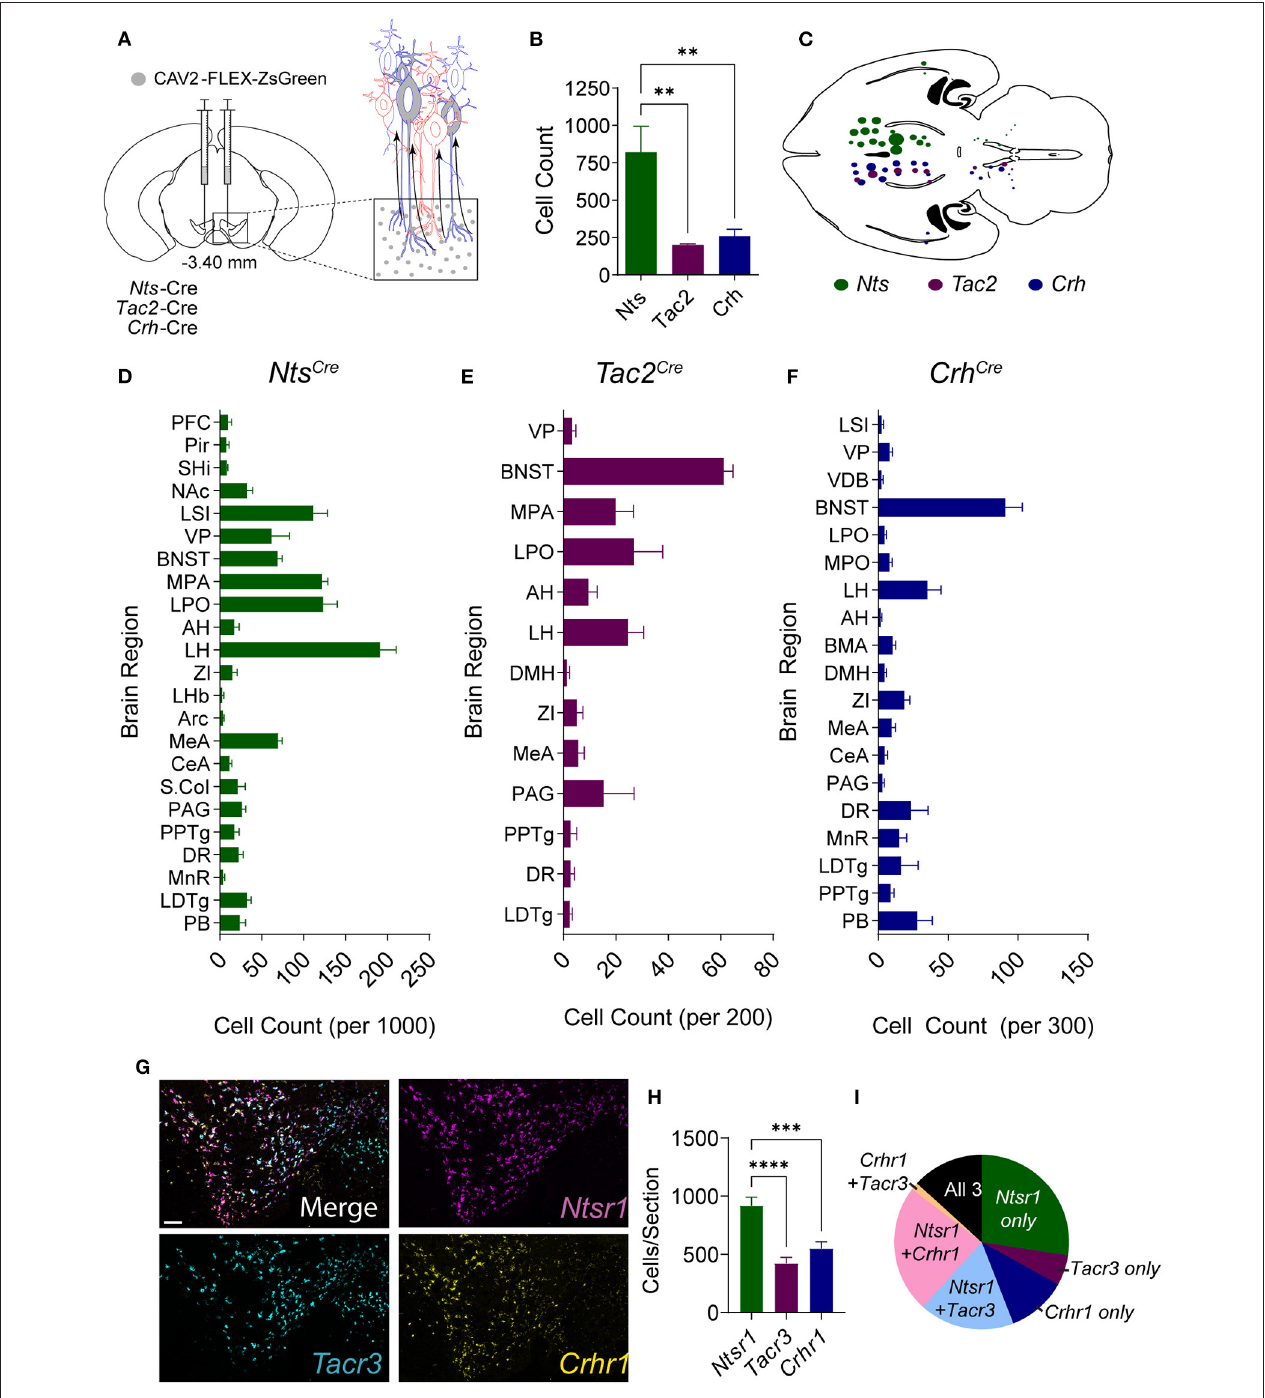
FIGURE 1 | Anatomical distribution of NTS, NkB, and CRF inputs to the VTA. (A) Schematic of injection strategy. CAV-FLEX-zsGreen was injected into the VTA of Nts -Cre, Tac2 -Cre, and Crh -Cre mice. The virus is taken up by axon terminals and transported retrogradely to the cell body, and zsGreen expression is turned on in Cre-positive neurons. (B) Total retrogradely labeled cells throughout the brain [ n = 5 Nts, 5 Tac2, and 6 Crh mice, One-way ANOVA F (2,13) = 6.141, P = 0.0133, Bonferroni multiple comparisons ** P < 0.01]. (C) Horizontal brain schematic showing distribution of retrogradely labeled cells in each Cre line. The size of the dot is proportional to the number of cells labeled in each region. (D–F) Counts of retrogradely labeled cells in each brain region normalized to the total number of labeled cells labeled per mouse. (G) Example images of in situ hybridization in the VTA for peptide receptors Ntsr1 (magenta), Tacr3 (cyan), and Crhr1 (yellow).